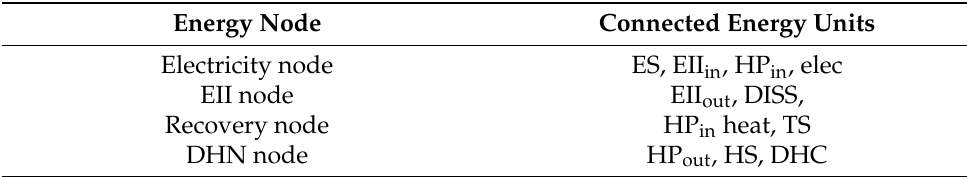
Table 3. List of energy nodes to define the energy balances to model the case